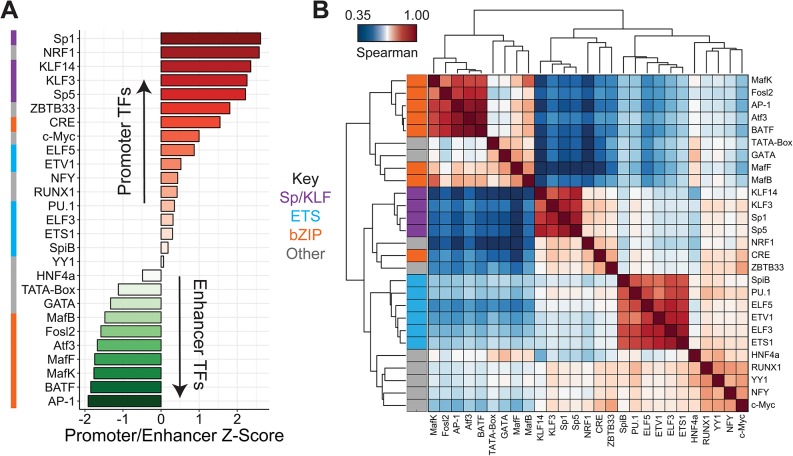
MPRA-DragoNN reveals patterns of transcription factor activity.(A) For each TF, we computed the ratio of average “usage” in promoter sequences relative to enhancer sequences. The plot contains z-scores of this ratio for 27 selected transcription factors, colored by their motif family (left). (B) Clustered correlation matrix of TF usage for the 27 factors from (A). Each cell is colored according to the motif usage Spearman correlation for a given pair of TFs across all ∼974,000 sequences. Rows are colored by their motif family.